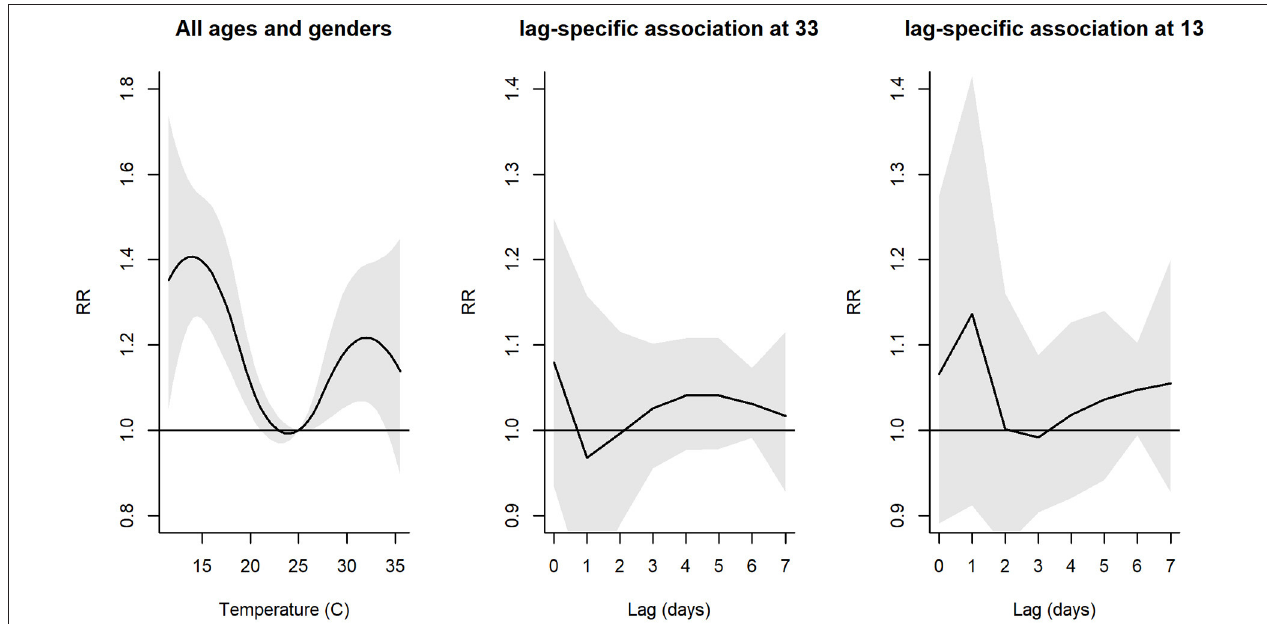
FIGURE 1 | Plot of overall relative risk (RR) between daily mean temperature and hospital admissions, and individual lag-response curves for hot and cold effects. Shaded areas denote 95% confidence intervals (CI).